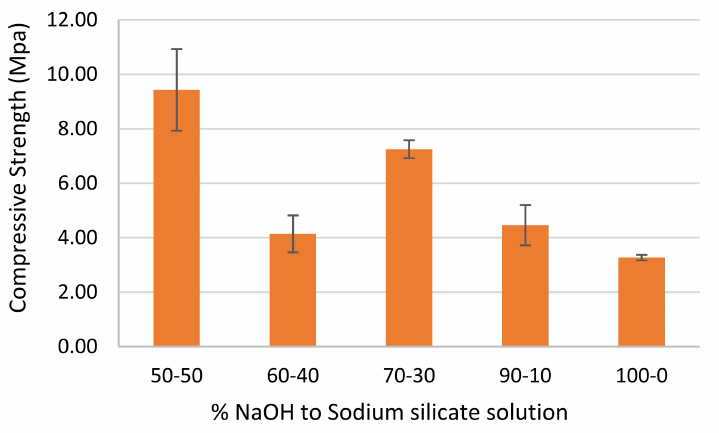
Figure 3. Effect of alkaline solution ratio on average 72 h compressive strength.